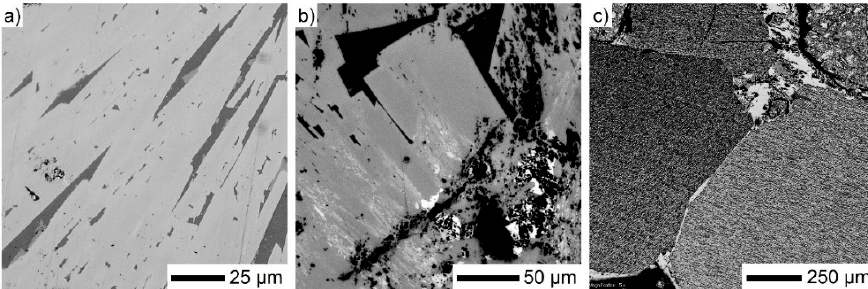
Figure 2. Reflected light micrographs of the samples: ( a ) SFCA prisms within sample PM-F, ( b ) SFCA crystals with iron oxide inclusions (white) in PM-A, ( c ) iron-aluminum oxide grains within sample PM-A.